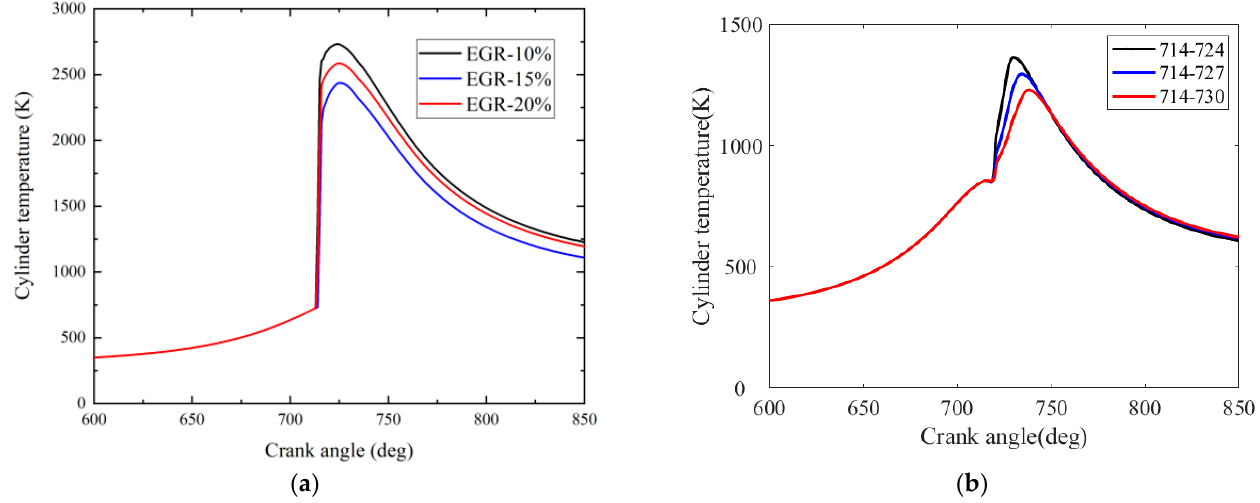
Figure 9. Average cylinder temperature for different EGR rates and injection durations: ( a ) different EGR rates; ( b ) different injection durations.